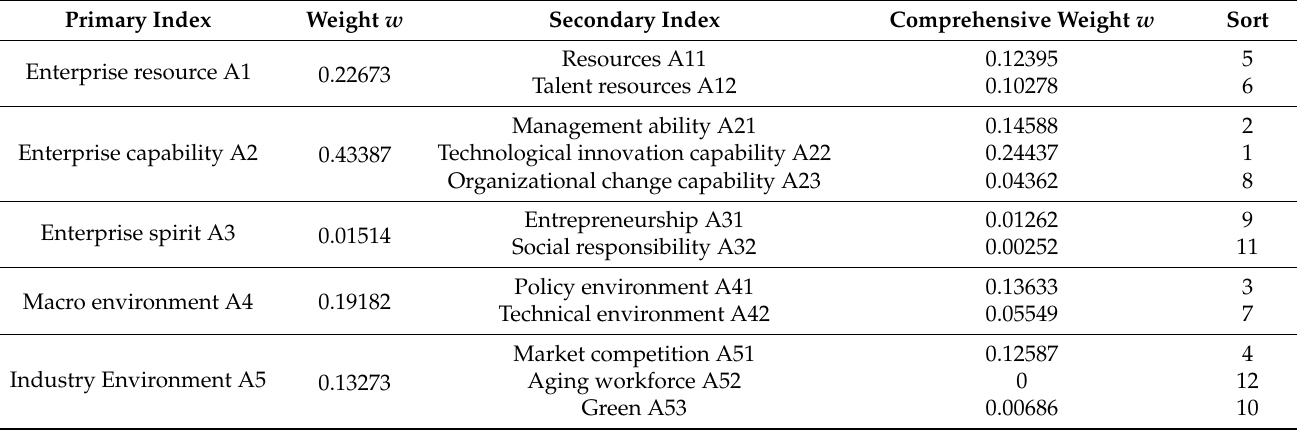
Table 9. Index weights of the comprehensive evaluation system for digital transformation of the construction